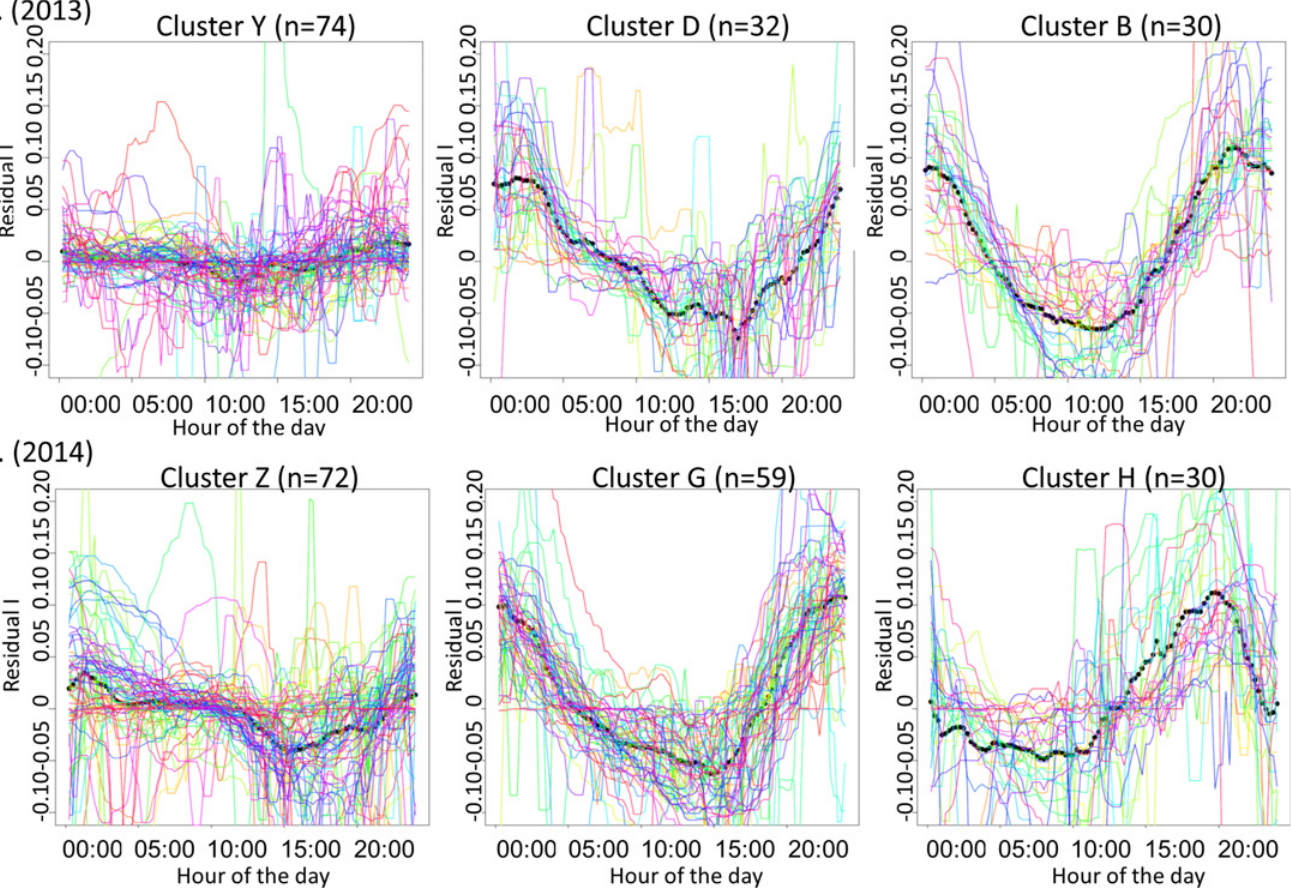
Fig 1. Primary clusters for 2013 (a) and 2014 (b). Names of the clusters are arbitrary. The black dotted line is the mean diurnal pattern. Each thin colored line represents one day. X-axis are hours (local time). Y-axis are detrended, smoothed nitrate concentrations, referred to as residual